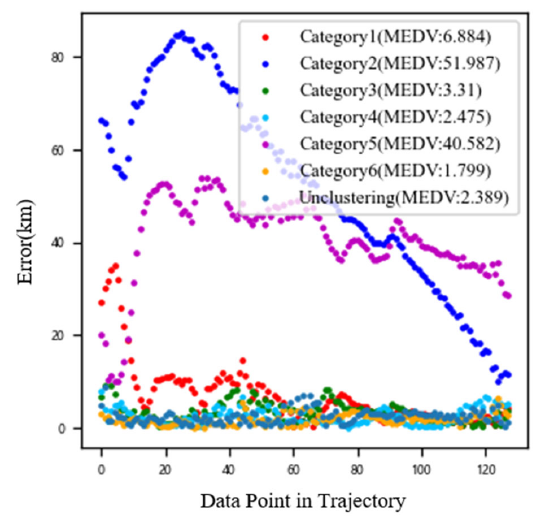
Figure 20. Error scatter plot of seven models.